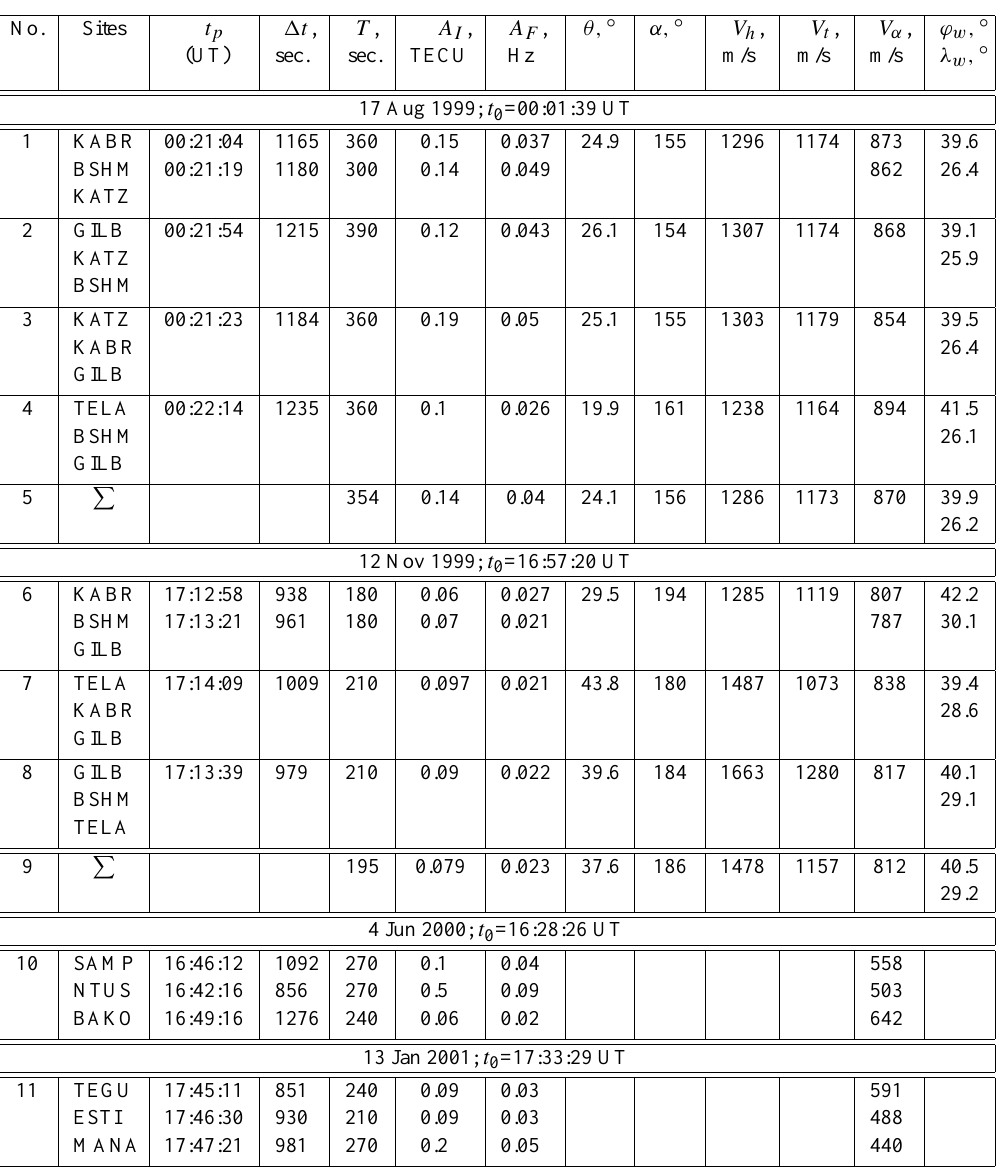
Table 3. The parameters of shock-acoustic waves